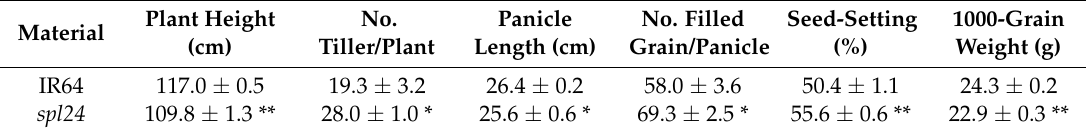
Table 1. Performance of agronomic traits in IR64 and spl24.